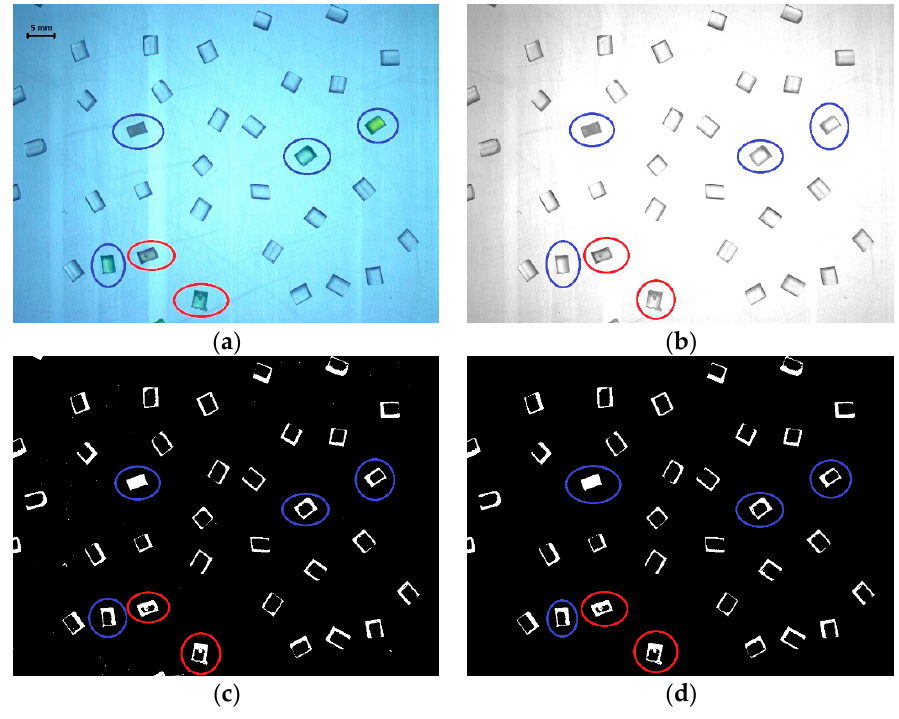
Figure 3. Image processing operations: ( a ) Original image; ( b ) RGB green color extraction and brightness settings; ( c ) Modified Sauvola threshold; ( d ) Particle filter. Blue color indicates marked pellets with color defects and red color indicates pellets with structural defects.